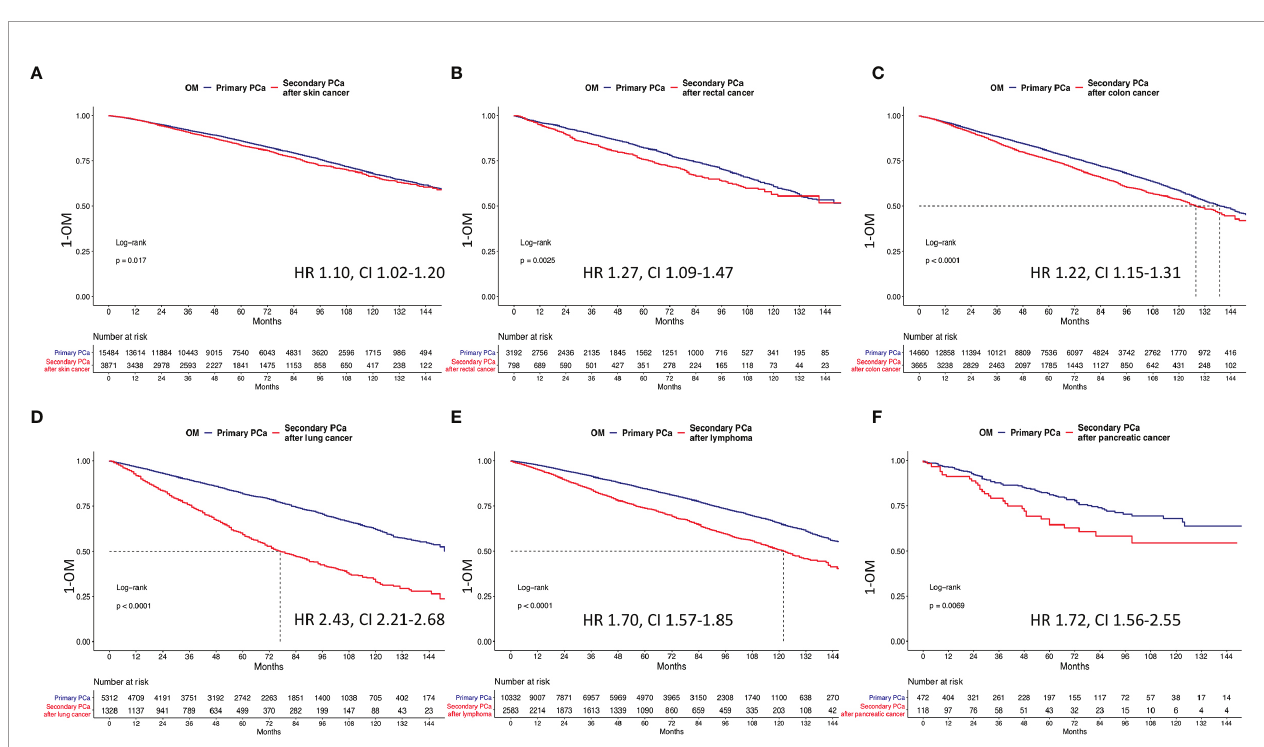
FIGURE 3 | Kaplan-Meier plots depicting overall mortality (OM) for primary and secondary prostate cancer after (A) primary skin cancer, (B) primary rectum cancer, (C) primary colon cancer, (D) primary lung cancer, (E) primary lymphoma, and (F) primary pancreatic cancer. HR, hazard ratio; CI, con fi dence